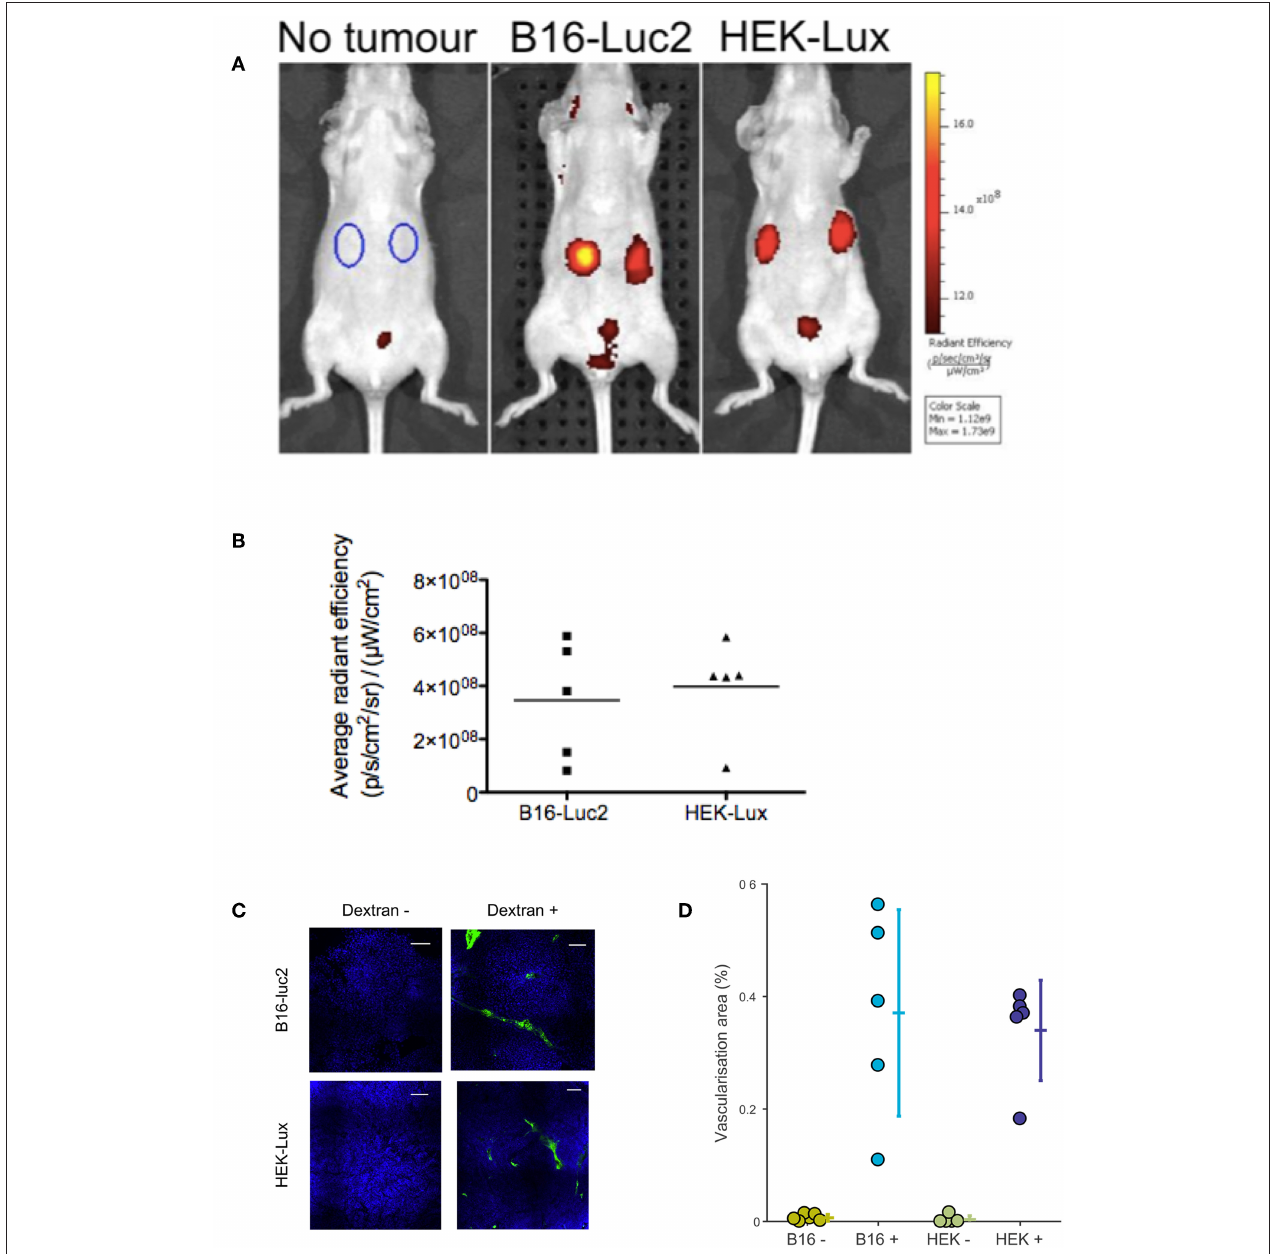
FIGURE 4 | In vivo evaluation of tumor vascularization. (A) B16-Luc2 cells (8 × 10 4 , 0.1mL), HEK-Lux (5 × 10 6 , 0.1mL) were subcutaneously administered in nude mice. Angiosense 750EX (2 nmol, 0.1mL) was intravenously administered between 7 and 9 days after B16-Luc2 injection or between 22 and 30 days post-HEK-Lux cells injection Images were acquired 24h after. (B) Fluorescence signal quantitation of Angiosense accumulation in B16-Luc2- and HEK-Lux-induced tumors. ROIs were determined as shown in the first image of Figure 3A . Results express the difference between the average radiant efficiency in the ROI of the left tumor of the mice with tumor and the arithmetic mean of the average radiant efficiency in the ROI of the left side in mice without tumor, ( n = 4 control group and n = 5 for the tumor bearing groups). (C) Visualization of tumor vascularization using high molecular weight dextran-FITC (500 KMW). Images correspond to a section in the tumors at 50% depth. Contrast and brightness in both channels have been adjusted with an identical color scale across the four images. Scale bars: 100 µ m. (D) Area of vascularization, defined as the percentage of the tumor area labeled by dextran at 0, 25, 50, 75, and 100% tumor depth. The area of vascularization was extracted using an identical threshold over all